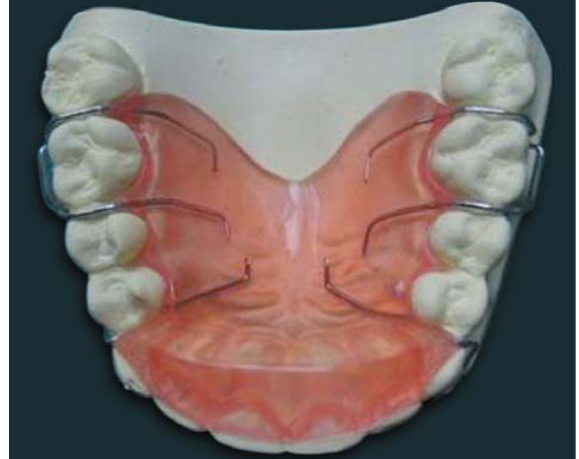
Figure 4- Posttreatment photograph of the same patient of Figure 3 treated by R-appliance Figure 5- Anterior Inclined Bite Plate